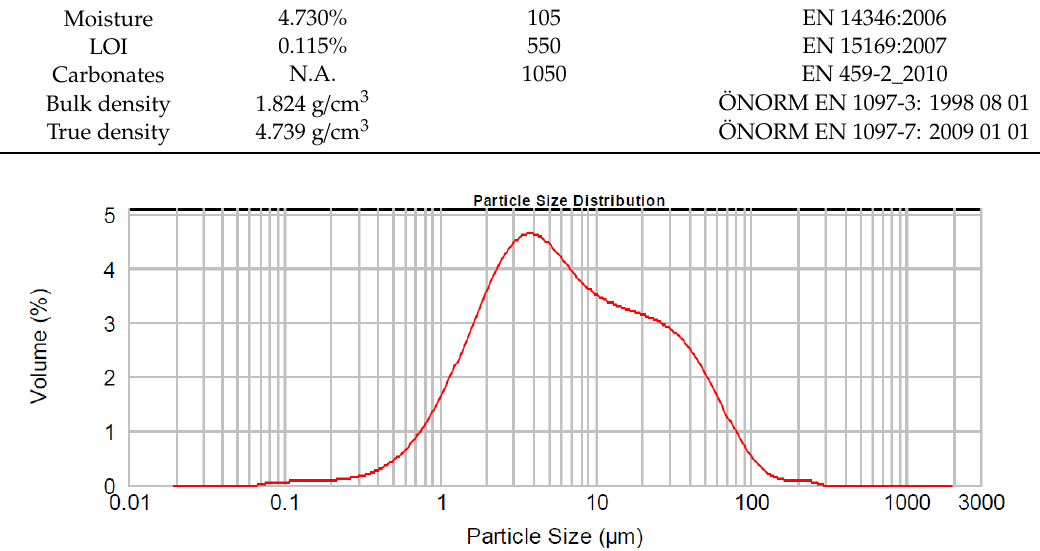
Table 5. Physical analysis of SIDENOR oxy-cutting fines samples.